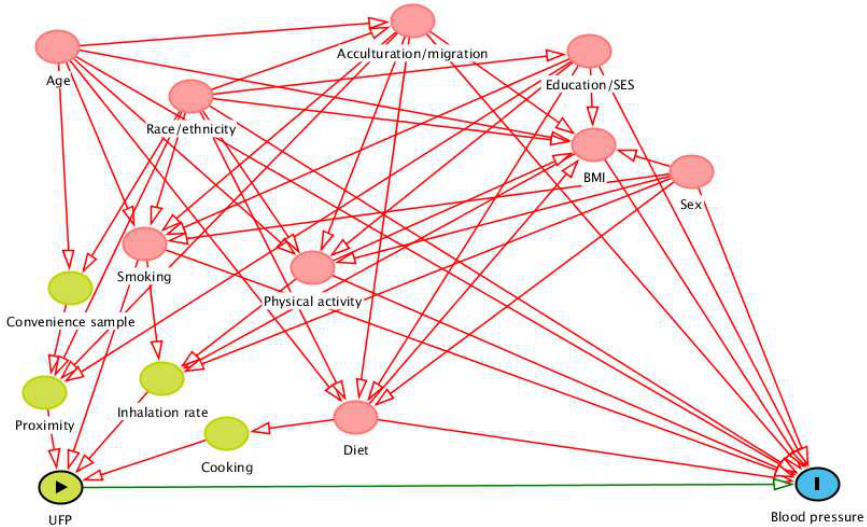
Figure 1. Directed acyclic graph representing the relationships among the exposure (UFP; represented by the green oval with the triangle), outcome (blood pressure; represented by the blue oval with the line), and related factors. Variables represented as pink ovals are ancestors of exposure and outcome while variables represented as green ovals (convenience sample, proximity, inhalation rate, and cooking) are ancestors only of the exposure. Pink lines are biasing paths and the green line between the exposure and outcome is the causal path of interest.